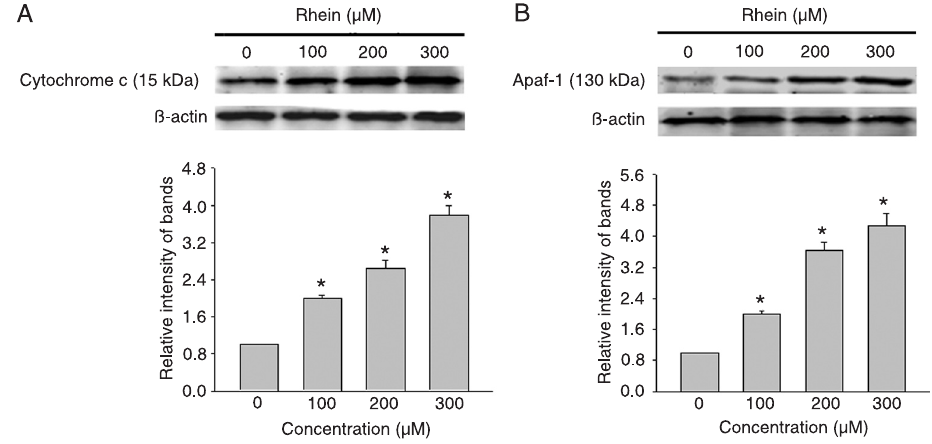
Figure 6. Treatment with rhein increased the expression of cytochrome c and Apaf-1 in SGC-7901 cells. SGC-7901 cells were treated with rhein (0, 100, 200, or 300 µM) for 48 h and protein levels of cytochrome c ( A ) and Apaf-1 ( B ) were determined by Western blot. Data are reported as the means ± SEM of at least three experiments. *P < 0.05 versus control group (0 µM) (one-way ANOVA followed by the Tukey post hoc